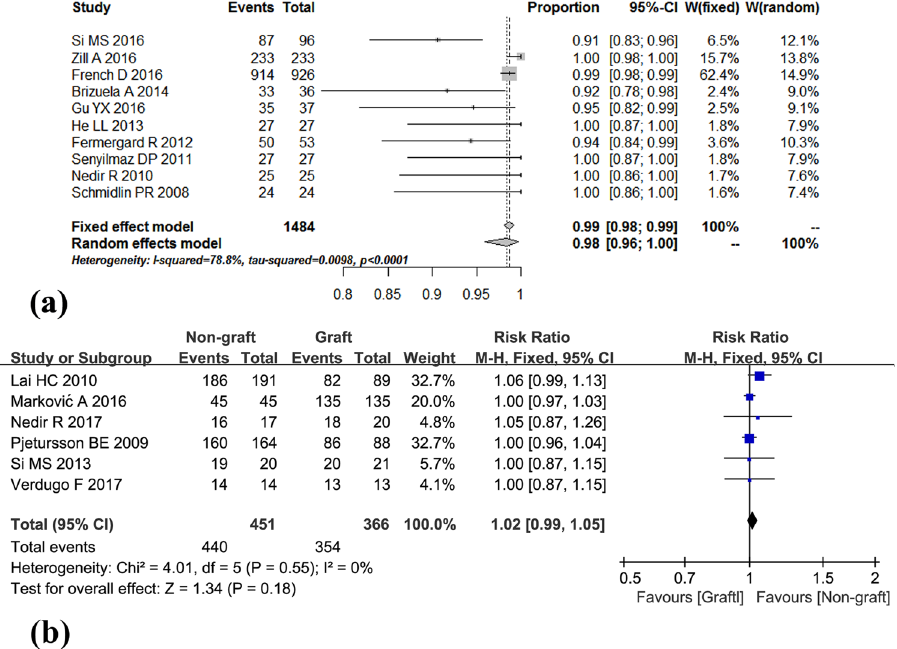
Figure 3. Forest plots of survival rates. ( a ) Forest plot of survival rate for non-controlled studies. ( b ) Forest plot of survival rate for controlled studies.